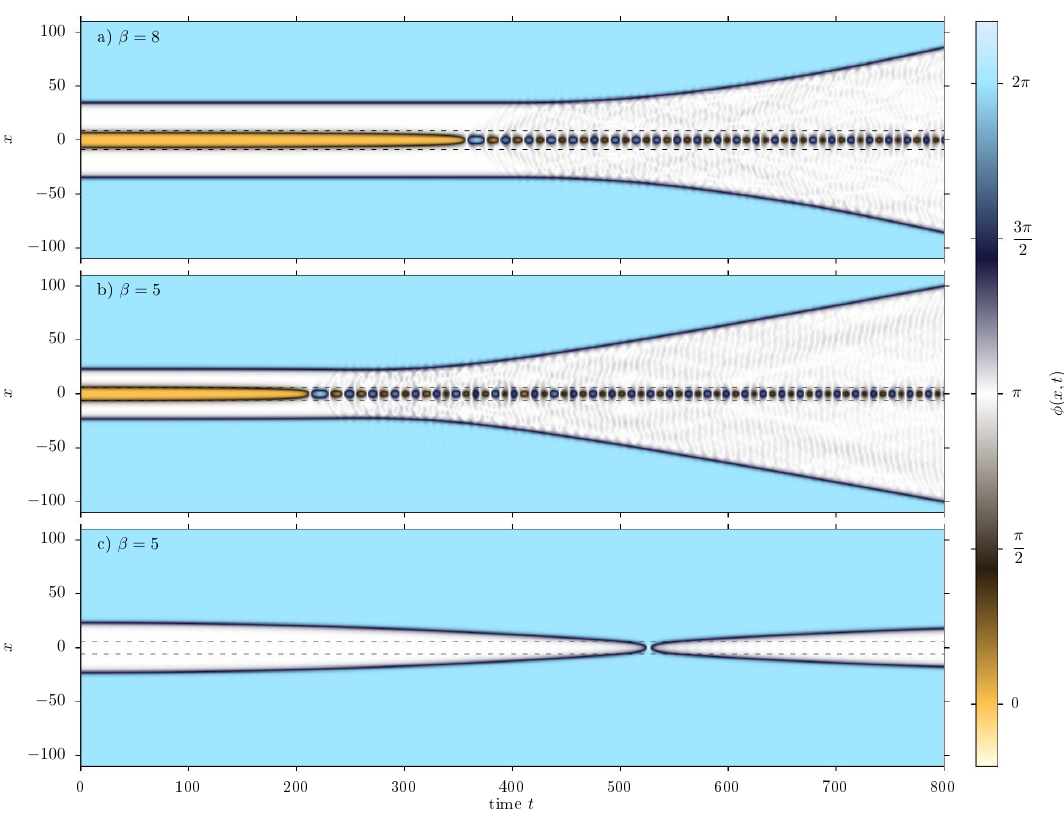
Figure 29 . “Blowing bubbles”: two static kinks placed close to each other, for two values of (cid:15) near to (cid:15) cr . The innermost subkinks attract each other and annihilate to create a bion, the radiation from which pushes the outer subkinks apart, thereby expanding the region of false vacuum. The final plot depicts the field evolution for the second case with the innermost subkinks removed, showing the collapse (and rebound) of the false vacuum bubble in the absence of radiation